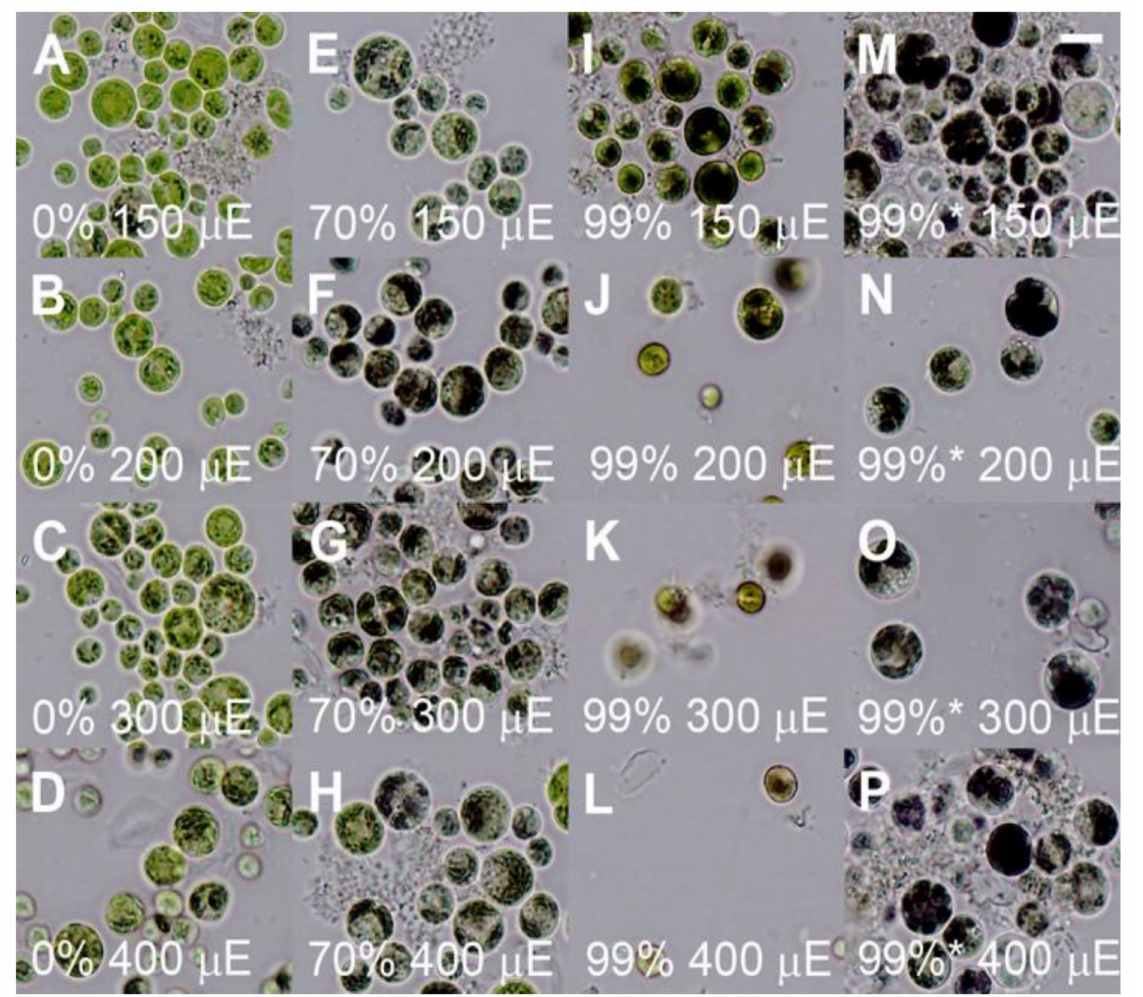
Figure 9. Light photo-micrographs of Parachlorella kessleri grown for 3 days at different incident light intensities (400, 300, 200, and 150 µ mol photons m − 2 s − 1 ) and different concentrations of deuterated water in the medium (0, 70 and 99%). ( A – D ): control cultures grown in 0% D 2 O, ( E – H ) cultures grown in 70% D 2 O, ( I – L ) cultures grown in 99% D 2 O, ( M – P ) cultures grown in 99% D 2 O and pre-adapted to the same concentration for one week. The cultures pre-adapted to growth at 99% of deuterated water for one week are denoted with asterisk. Scale is 10 µ